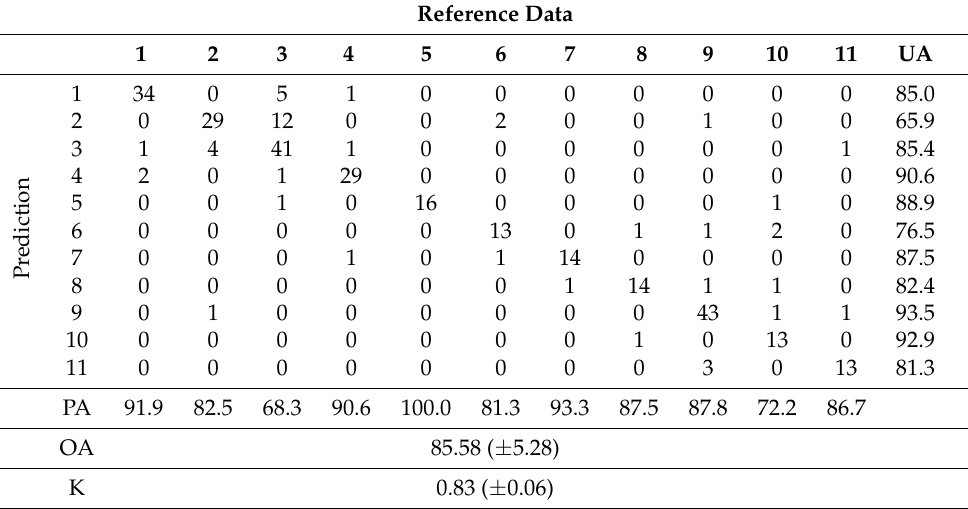
Table 4. Cross-validated confusion matrix (10-fold, repeated five times) between the predicted target classes of the SAC “Gola di Frasassi”, code IT5320003 (Central Italy). The Overall accuracy, Producer accuracy, User accuracy (in percentage), and κ Statistic are given. Row and column numbers denote the plant associations and habitats listed in Table